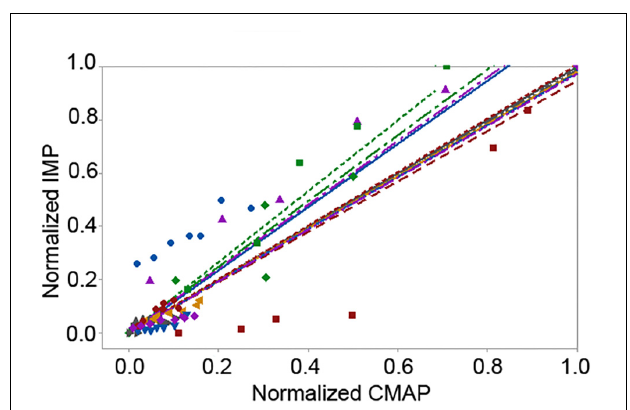
FIGURE 5 | Scattered plot of the linear fit of the pooled normalized area of the intramuscular pressure (IMP) response with respect to the pooled normalized area of the compound muscle action potential (CMAP) levels up to the maximum CMAP. Different colors and shapes indicate different